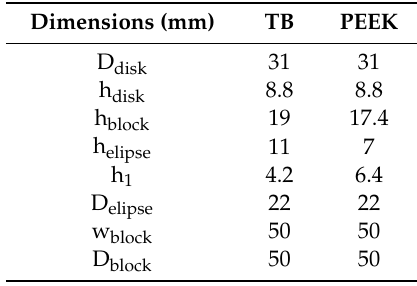
Table 2. Sensor dimension values for PEEK and TB.